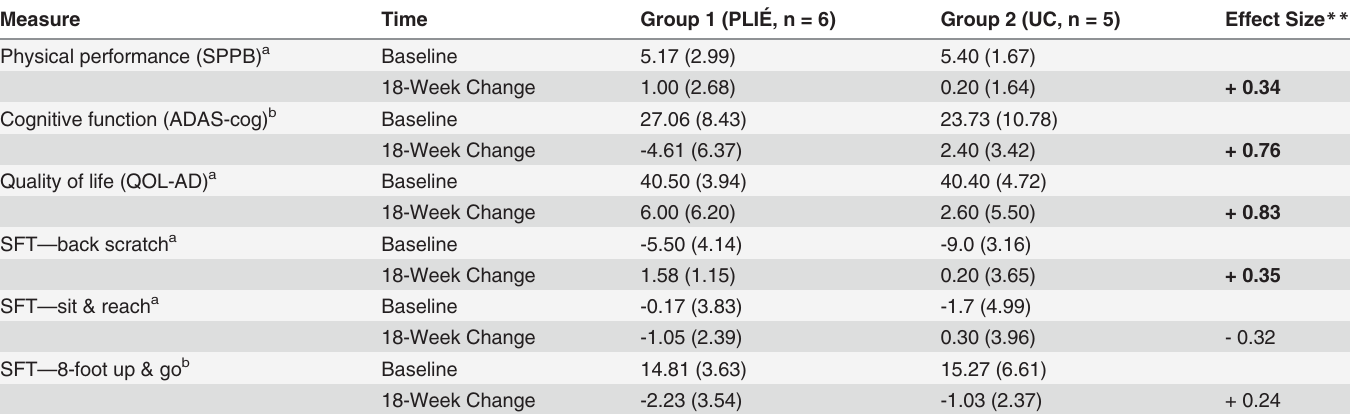
Table 3. Between-Group Effect Sizes in Participant Measures * , Baseline to 18 Weeks.